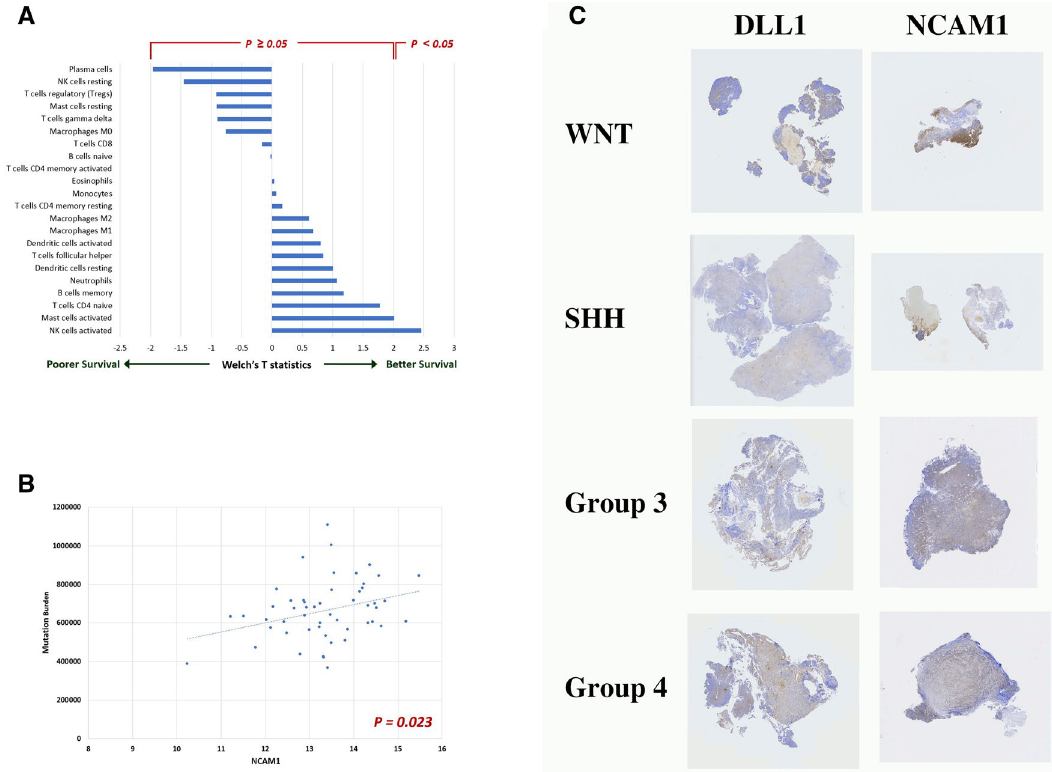
Figure 3. Tumor infiltrating immune cells inferred from the de-convoluted transcriptome and confirmed by immunohistochemical staining. ( A ) A comparison of 22 types of tumor infiltrating immune cells between patients with distinct prognosis. The natural killer (NK) cells manifest significantly higher quantity in patients with better prognosis (P = 0.020). The mast cells manifest borderline significance (P = 0.050). ( B ) The linear relationship between the NCAM1 ( a.k.a. CD56) level, a representative biomarker of NK, and the somatic mutation burden (P = 0.023). ( C ) The immunohistochemistry staining of DLL1 and NCAM1 in tumor tissues of 8 medulloblastoma patients. The detected DLL1 and NCAM1 proteins are shown as brown color in the